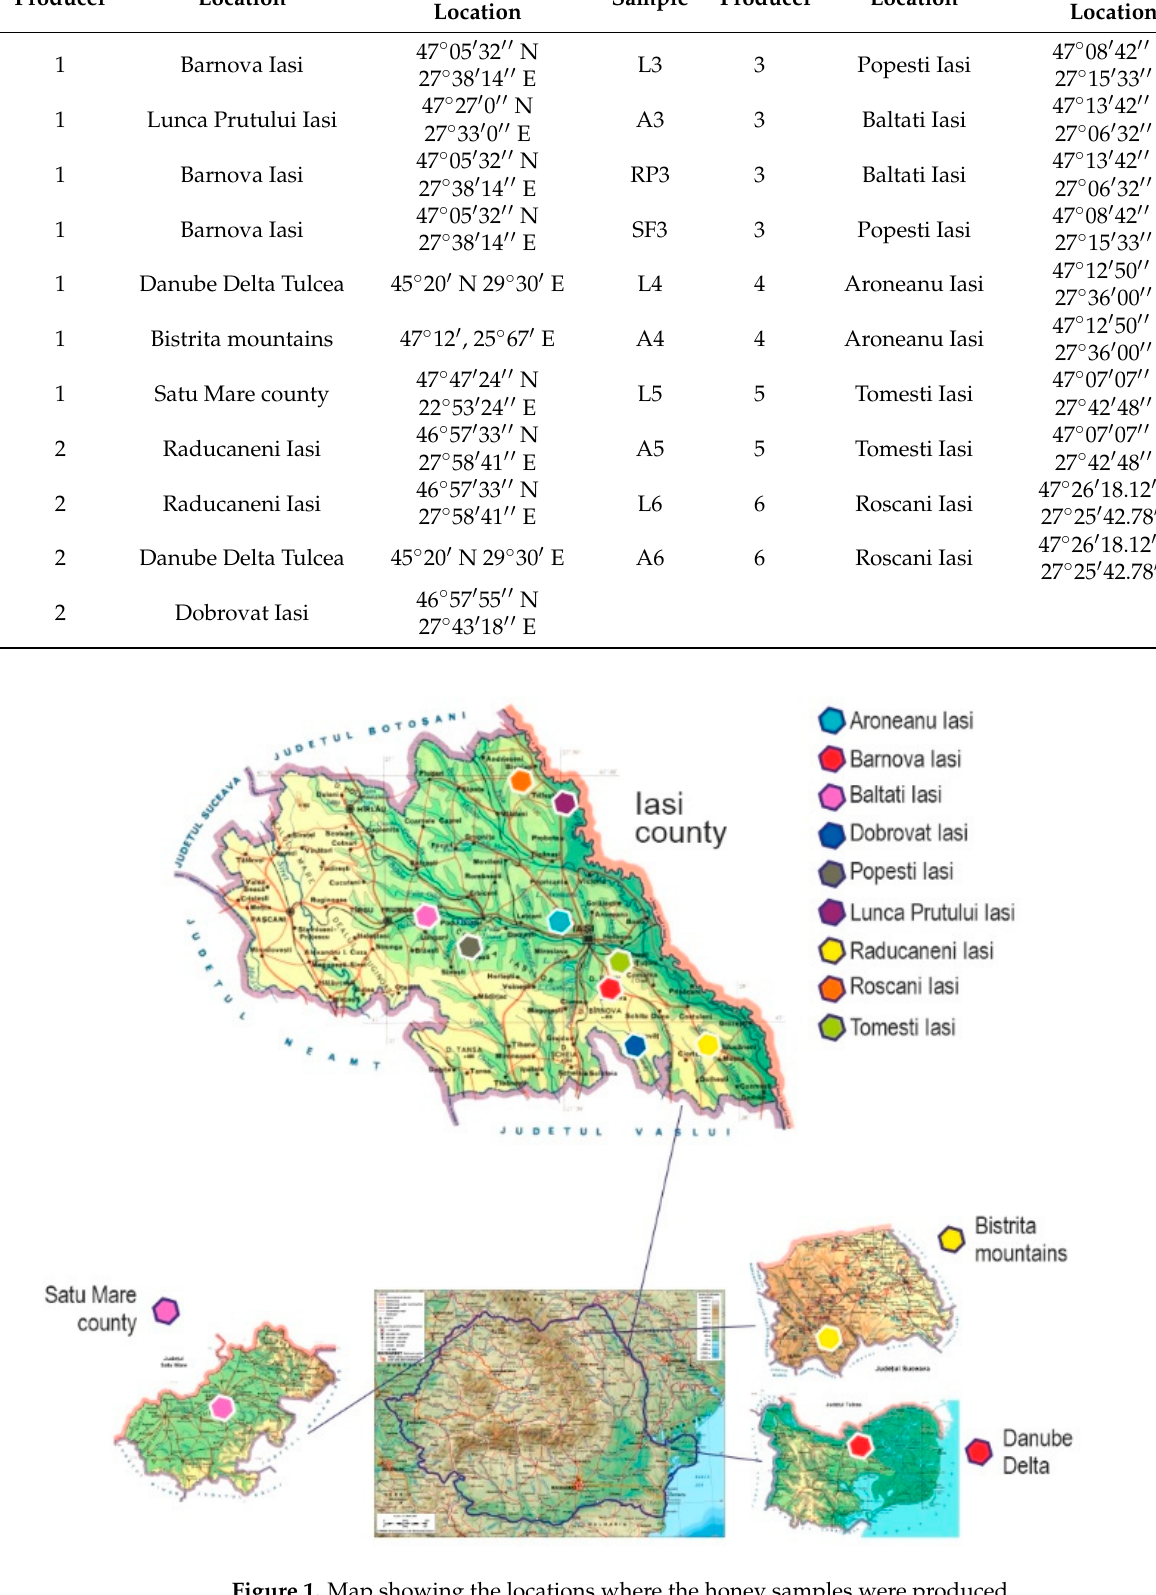
Figure 1. Map showing the locations where the honey samples were